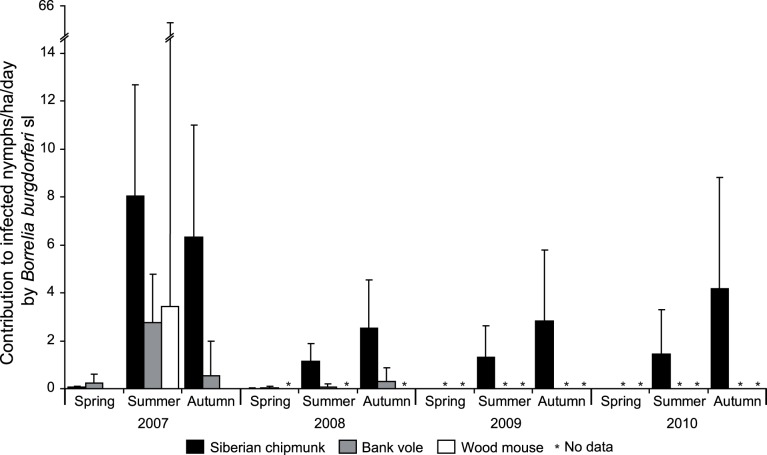
Estimated contributions to Lyme borreliosis (Borrelia burgdorferi sensu lato) risk of Siberian chipmunks, bank voles and wood mice.The contributions were estimated for Siberian chipmunks between 2007 and 2010, for bank voles in 2007 and 2008 and for wood mice in 2007, for 3 periods (spring, summer, autumn). Error bars are associated 95% confidence intervals.